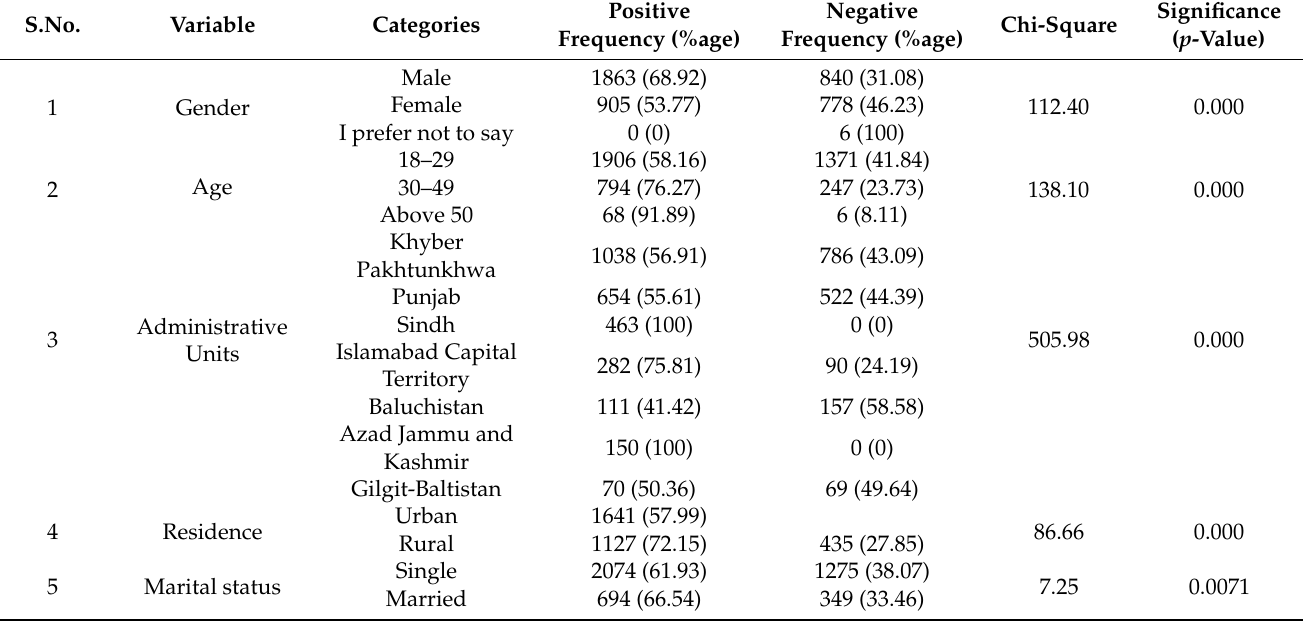
Table 3. Association between Attitude and demographic variables ( n =